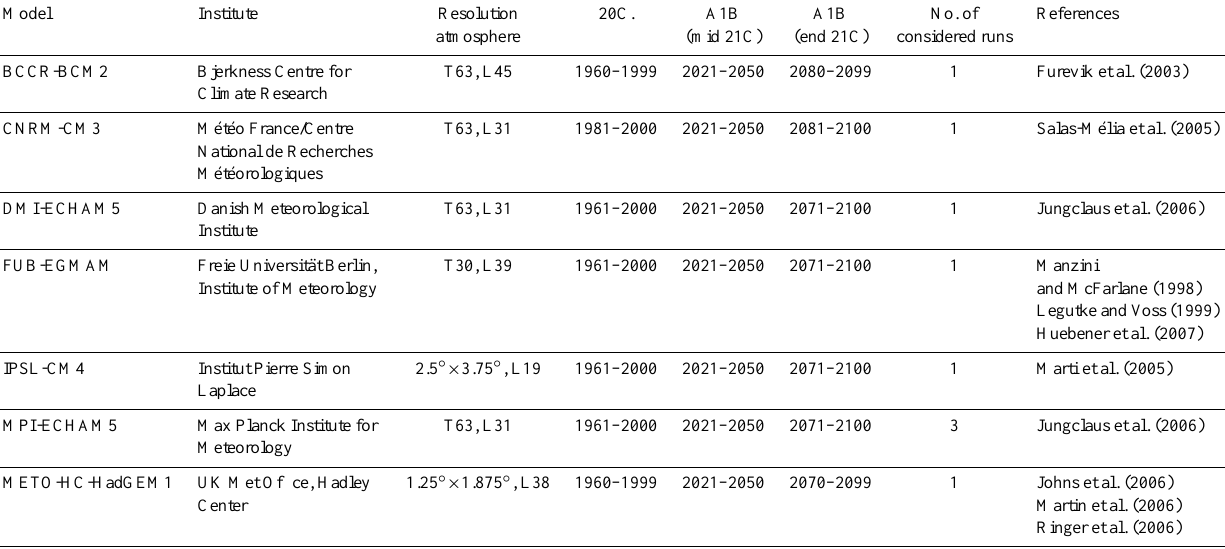
Table 1. a Climate models included in this study (ENSEMBLES setup) (a) GCM simulations.